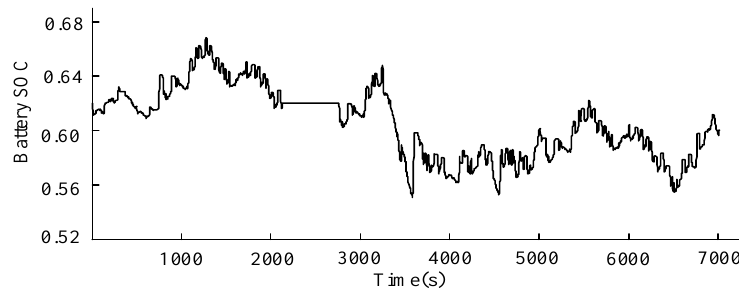
Figure 6. Variation of battery SOC under the comprehensive cycle conditions.